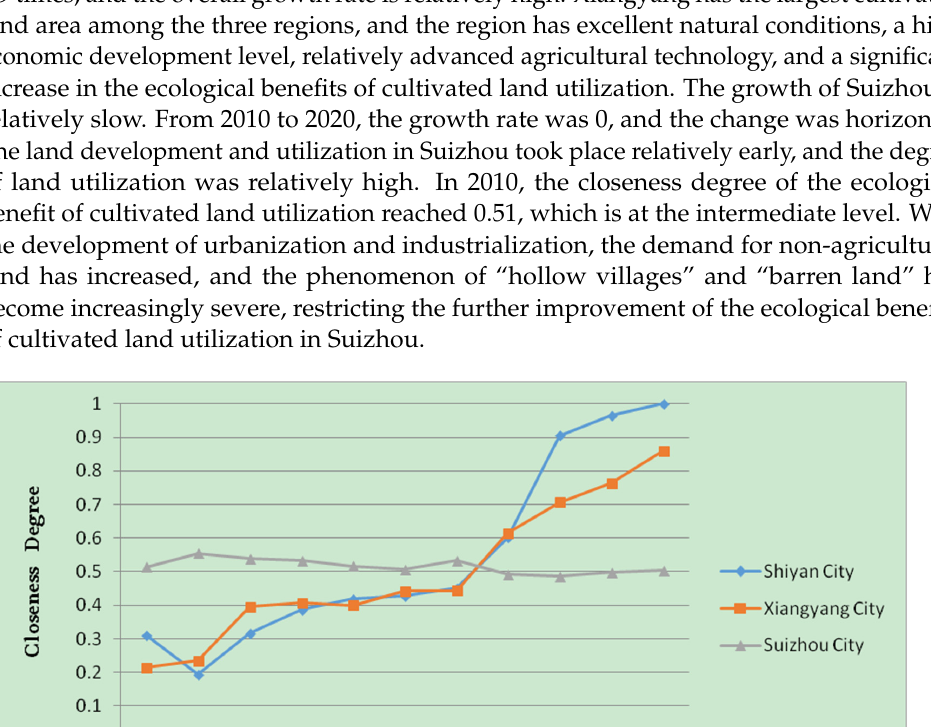
Figure 3. The closeness degree of the economic benefits of cultivated land use in three study areas during 2010–2020.